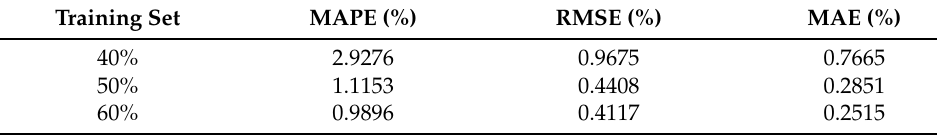
Figure 9. Error of FC2 for degradation prediction with different training set sizes. Table 3. Prediction performance with different training set sizes for